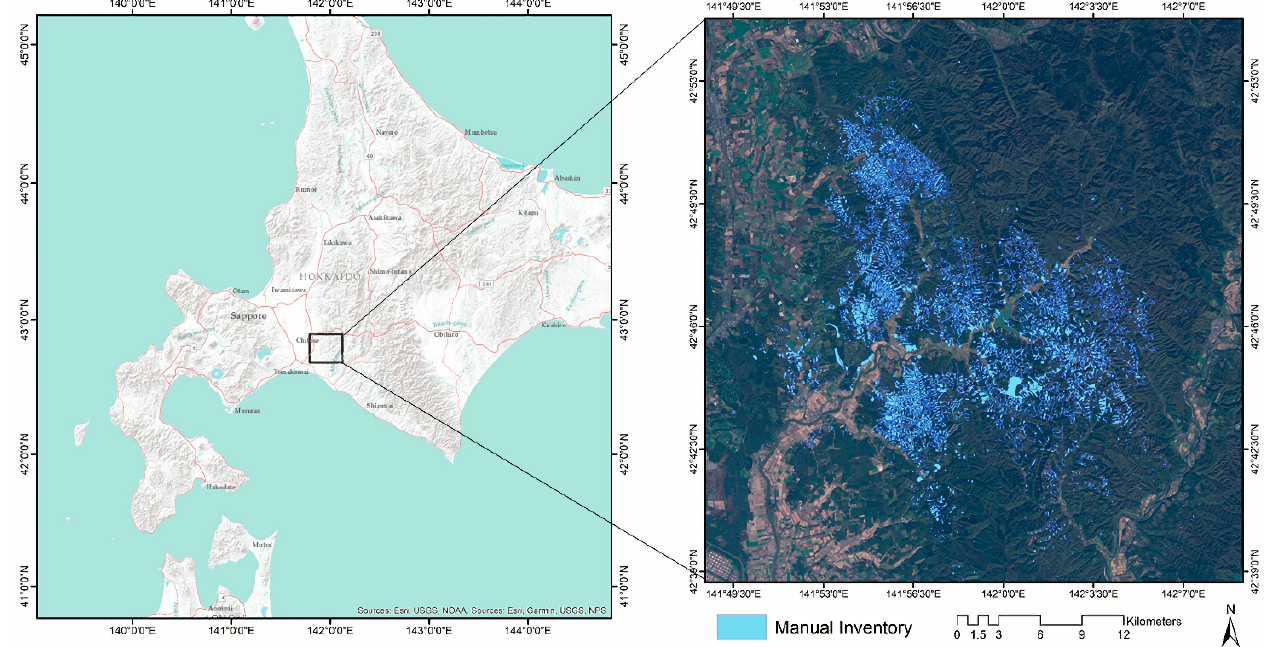
Figure 1. Geographic location of the study area in Hokkaido, Japan, and landslides identified by Wang et al. [6].